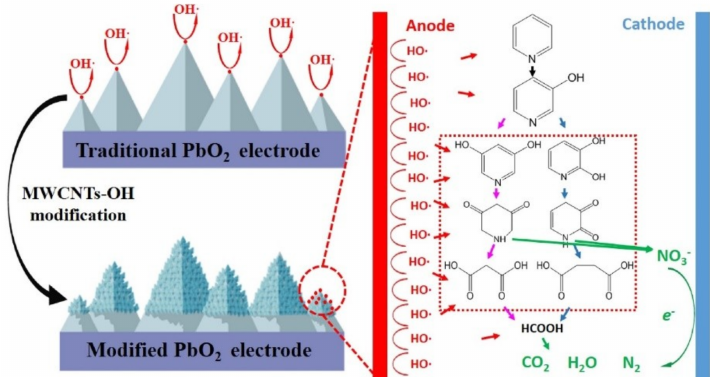
Figure 6. Hydroxyl multi-walled carbon nanotube-modified nanocrystalline PbO 2 anode for removal of pyridine from wastewater. Reproduced with permission from [80]. Copyright Elsevier, 2017.